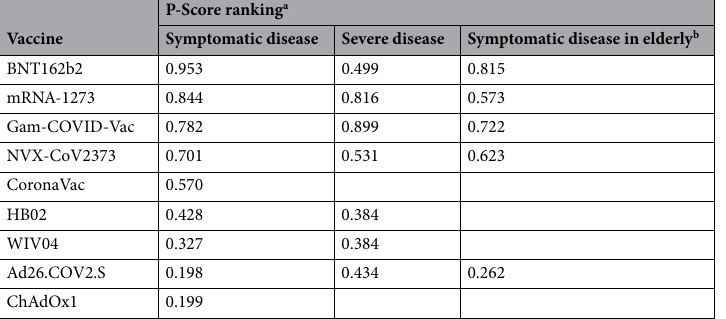
Table 2. P-Score ranking vaccines’ efficacy to prevent COVID-19. a P-score represents the probability of each intervention is being better than all competing interventions, derived from network point estimates and standard errors. b Subjects above 60 years.